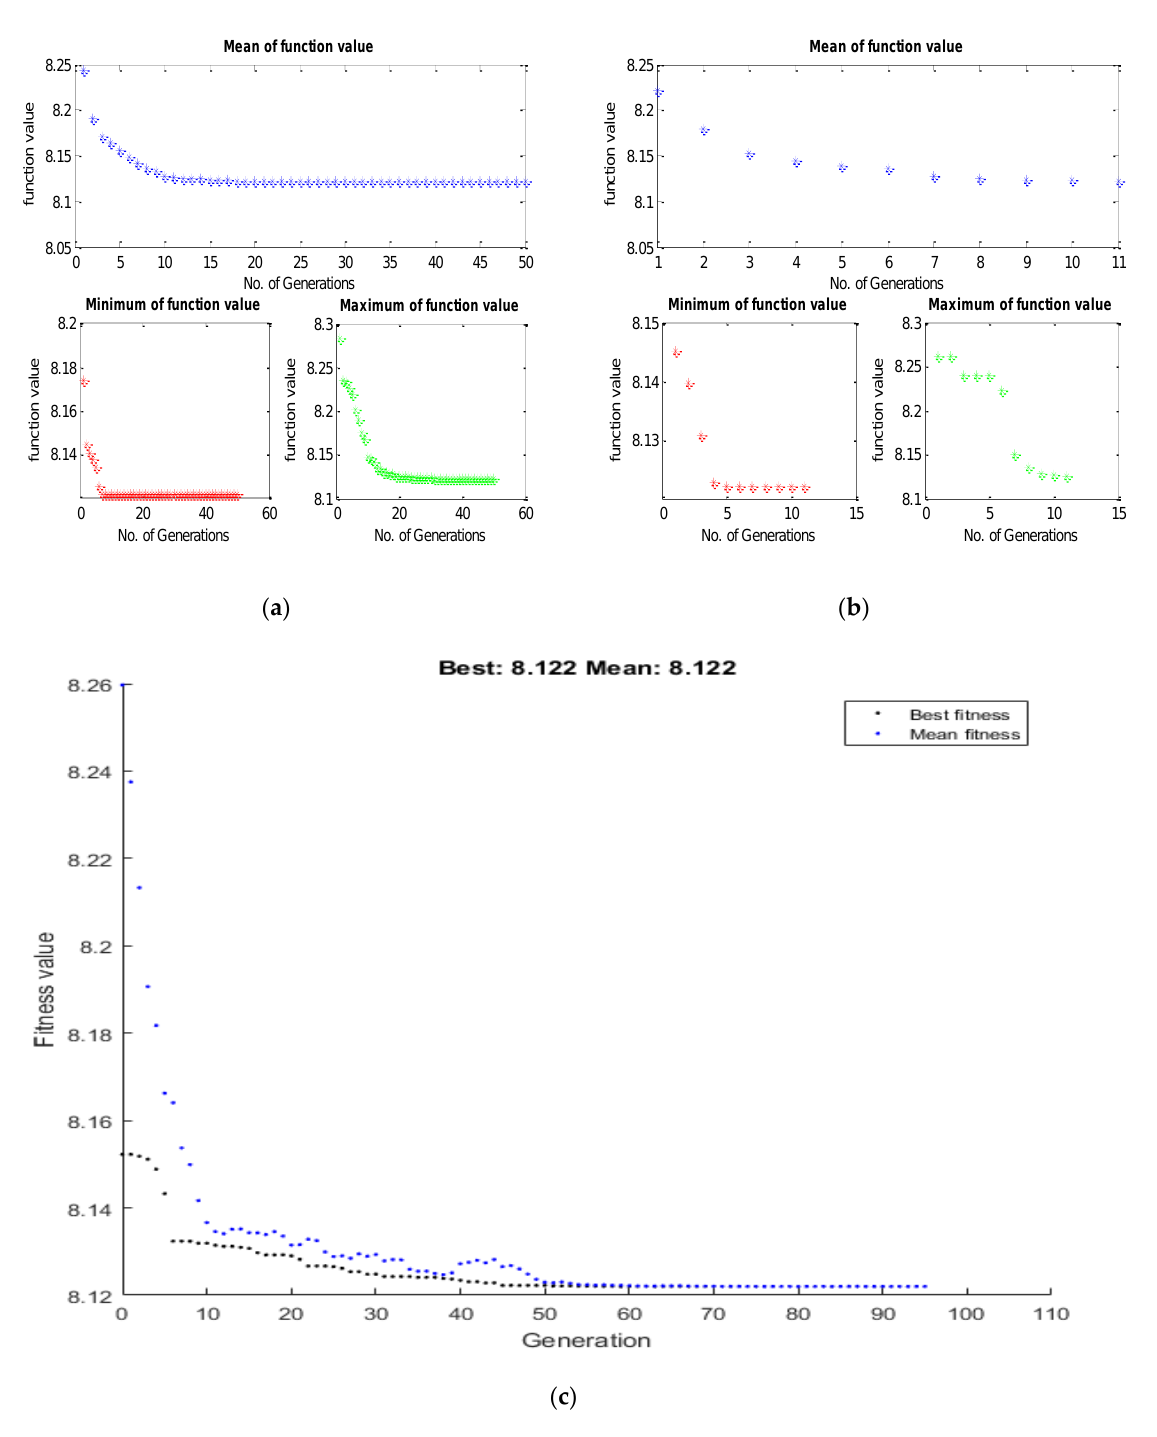
Figure 4. Convergence plot for the surface roughness by ( a ) TLBO ( b ) JAYA & ( c ) Genetic Algorithm.